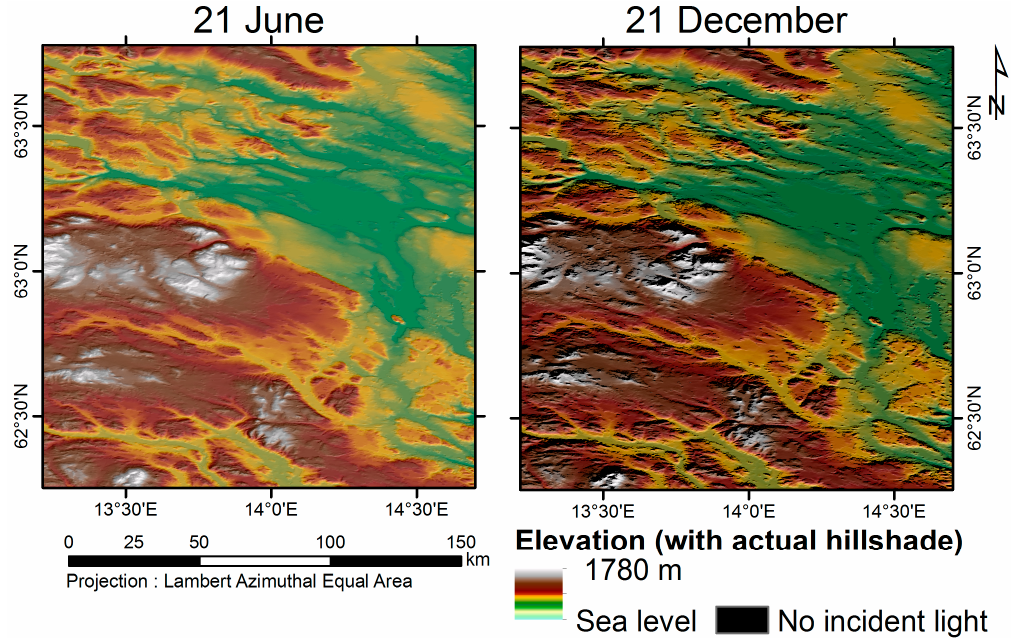
Figure 2. Representation of the impact of high Sun Zenith Angle SZA on shadows (no incident light) in a part of Scandinavia. The SZA in the center of the subsets is equal to 47.5° on 21 June 2015 and to 87.25° on the 21 December 2015 at the PROBA-V overpass time.